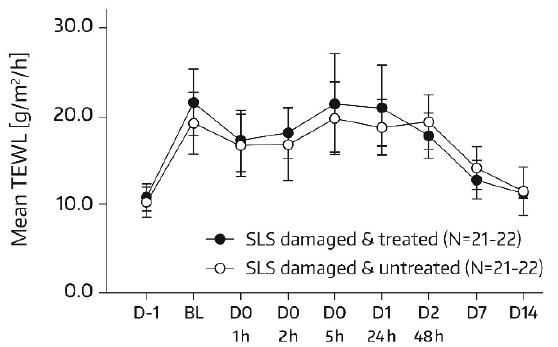
Figure 10. Results from TEWL measurements in untreated SLS-damaged skin and SLS-damaged skin undergoing a single application of Emollient 3 (first 48 h) followed by once-daily application for 12 days. The values are presented as mean ± SD. SLS challenge started on day -1 and ceased 24 h later (30 min before BL assessment). BL = Baseline TEWL value before first product application; D = day; h = hour; SLS = sodium lauryl sulfate.